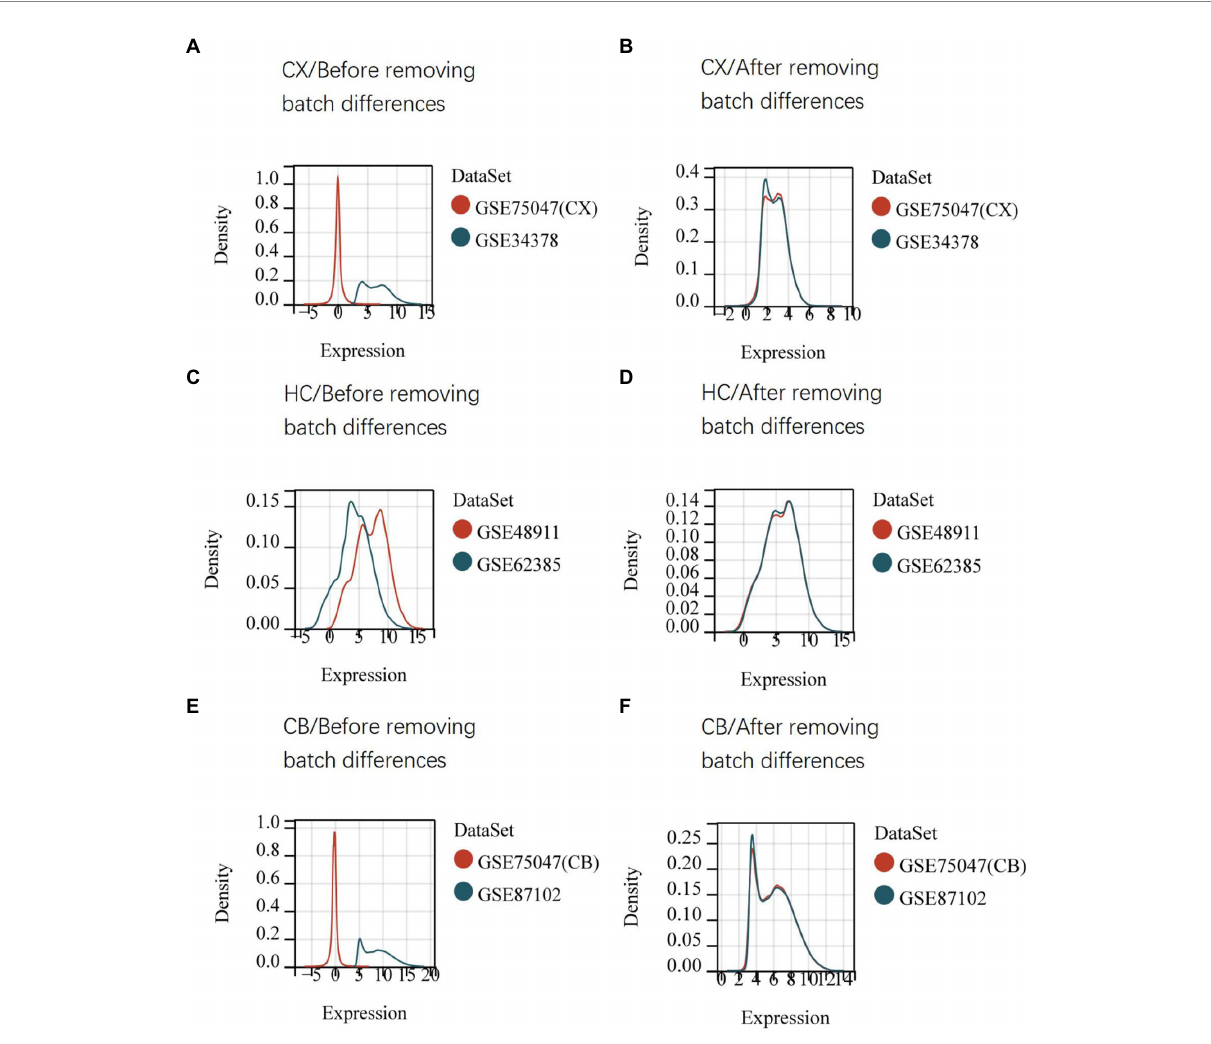
FIGURE 2 Density distribution map of gene expression in datasets before (A,C,E) and after (B,D,F) removing batch differences. The maps were generated by SangerBox using the ComBat method. The horizontal axis represents gene expression level and the vertical axis represents probability density. The higher curve overlap, the smaller batch differences. CX, cerebral cortex; HC, hippocampus; CB,